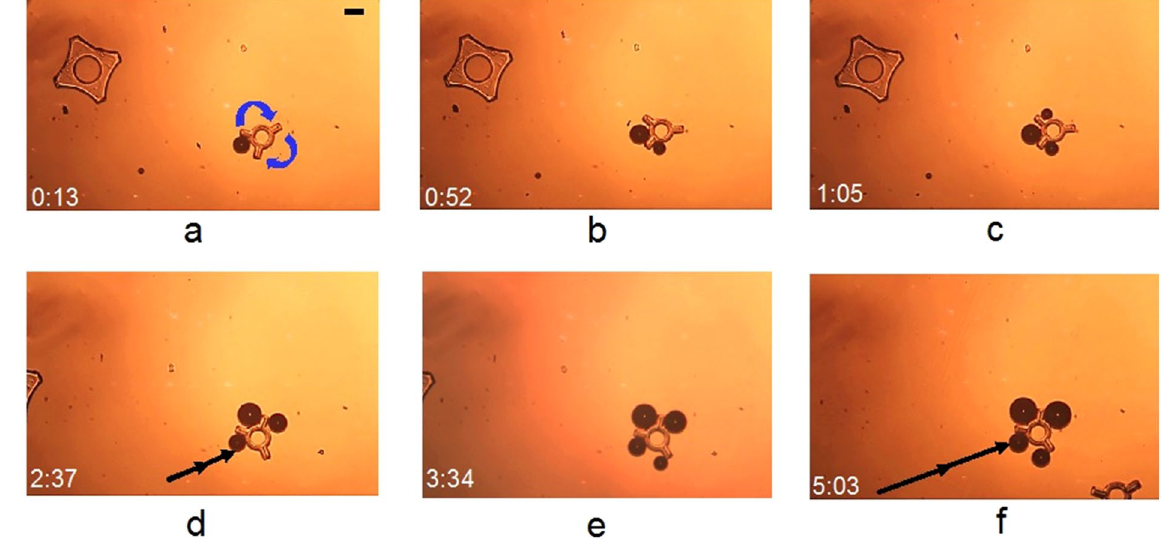
Figure 7. Micromanipulation by multiple microrobots. ( a ) A single OFB microrobot attempted to transport a star-like SU-8 microstructure but could only effect limited rotational movement. ( b ) A failed attempt to move the microstructure by two OFB microrobots. ( c, d ) Three OFB microrobots were able to transport the microstructure along a linear path at a speed of 8 µ m·s − 1 . The micro-object was transported over a distance of 490 µ m. ( e,f ) Four OFB microrobots grasping the same microstructure and transporting it along the similar linear trajectory. The micro object was carried over a distance of 1890 µ m at 22 µ m·s − 1 . Scale bar: 100 µ m. Time format: minutes:seconds.